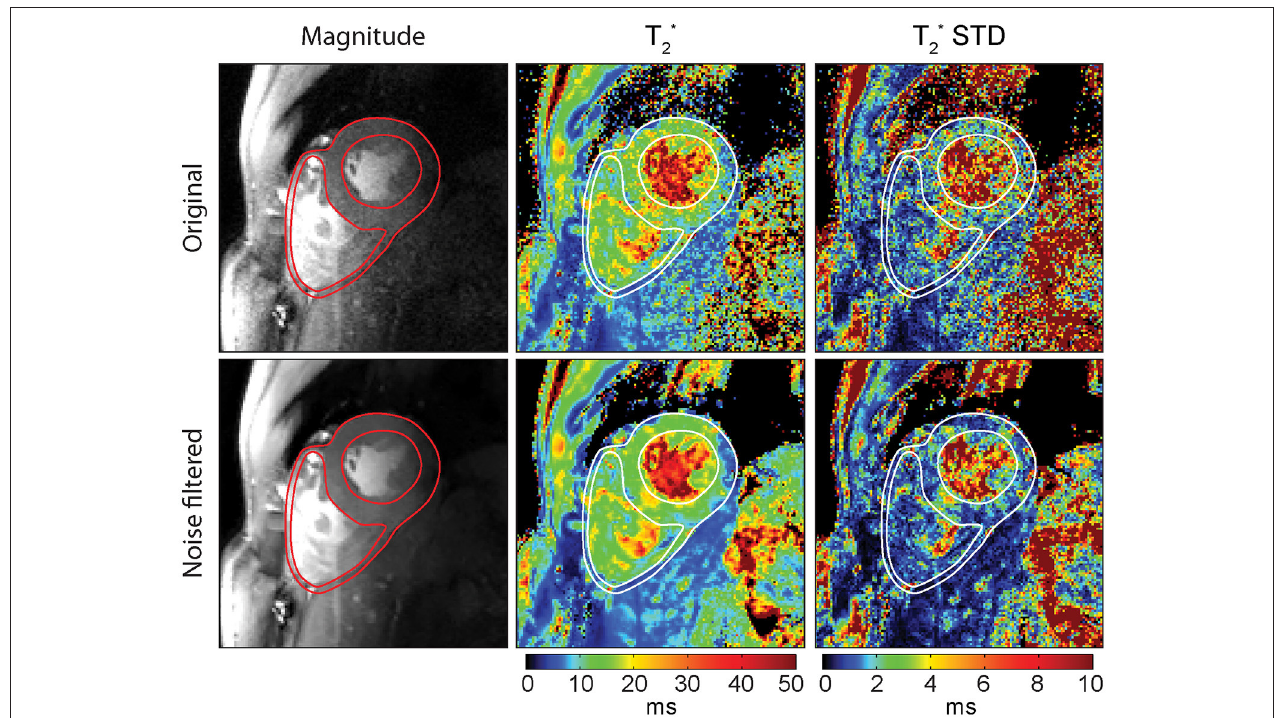
FIGURE 10 | Impact of spatially adaptive non-local means (SANLM) noise filtering on T 2 * maps of a mid-ventricular short axis view of the heart. Left: Original and SANLM filtered signal magnitude images of the first echo (TE = 2.04 ms) of a series of multi-echo gradient echo images. Center: Corresponding T 2 * maps. Right: T 2 * standard deviation maps illustrating the precision of the T 2 * maps. By applying the noise filter, an average decrease in T 2 * fit standard deviation of about 30% in the left ventricular myocardium was